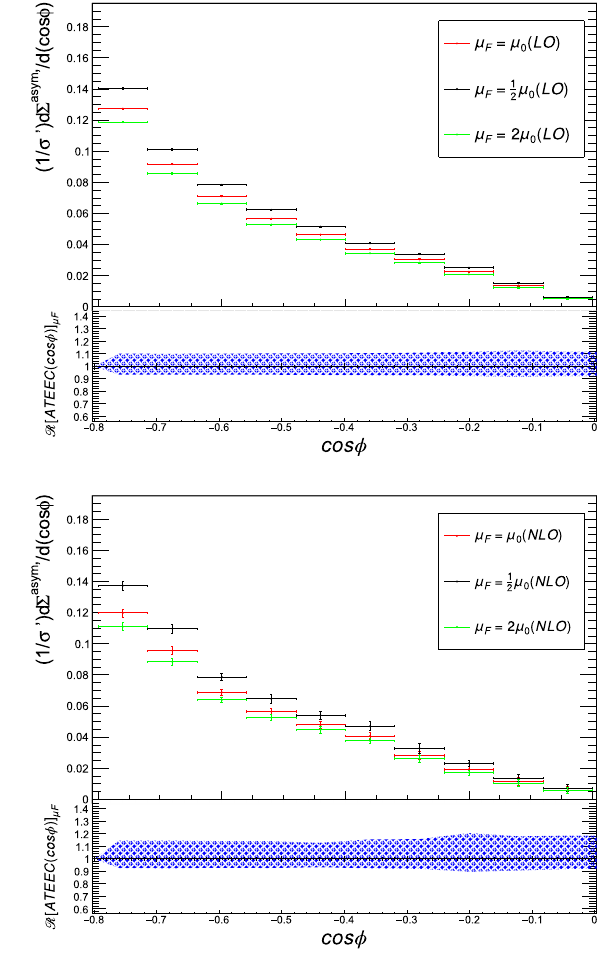
Fig. 4 Fatorization scale dependence of the differential distribution 1 /σ (cid:7) d (cid:9) (cid:7) / d ( cos φ) and its asymmetry 1 /σ (cid:7) d (cid:9) (cid:7) asym / d ( cos φ) in the leading order (upper frames), and the next to leading order (lower frames), varying μ F in the range [ 0 . 5 , 2 ] × μ 0 , where μ 0 is the nom-